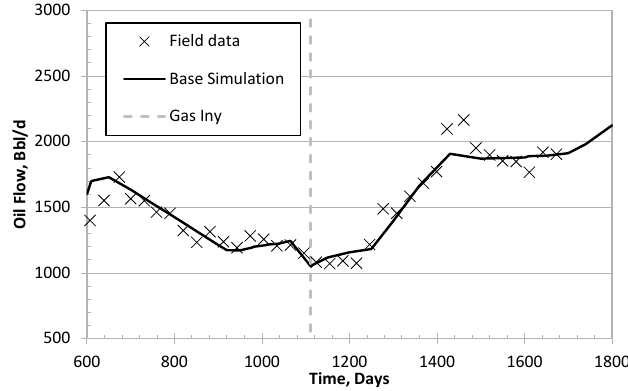
Figure 18. Oil production. Symbols: field measurements; continuous line: baseline.